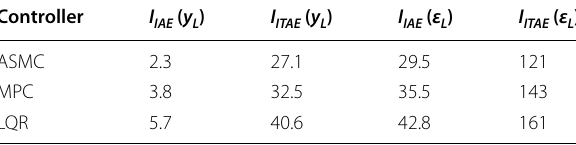
Table 2 Error performance indexes in experimental test I Controller